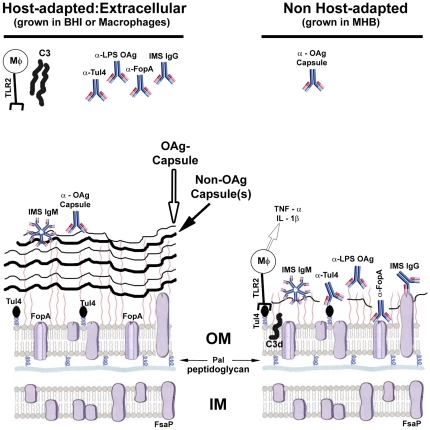
A model of the interaction of MHB-grown and host-adapted F. tularensis with select mammalian immune effectors.The cellular locations depicted for FopA, Tul4, Pal, and FsaP are based upon data in figure 2A and the relevant text in which this data is discussed. The depiction of host-adapted bacteria having longer LPS O-Ag carbohydrate chains and elevated levels of capsular material is based upon results in figures 2B, 3, 4, 6A, 7A, S2, and S3. The depiction of antibodies binding differentially to host-adapted and non-adapted bacteria is based on results presented in figures 3, 4, and 6. The differential binding/activation of complement protein C3 is based upon data in figures 5 and S4. Our model of TLR2-dependent production of TH1-type pro-inflammatory cytokines by macrophages responding to F. tularensis is based upon results presented in figures 6B and 7B.